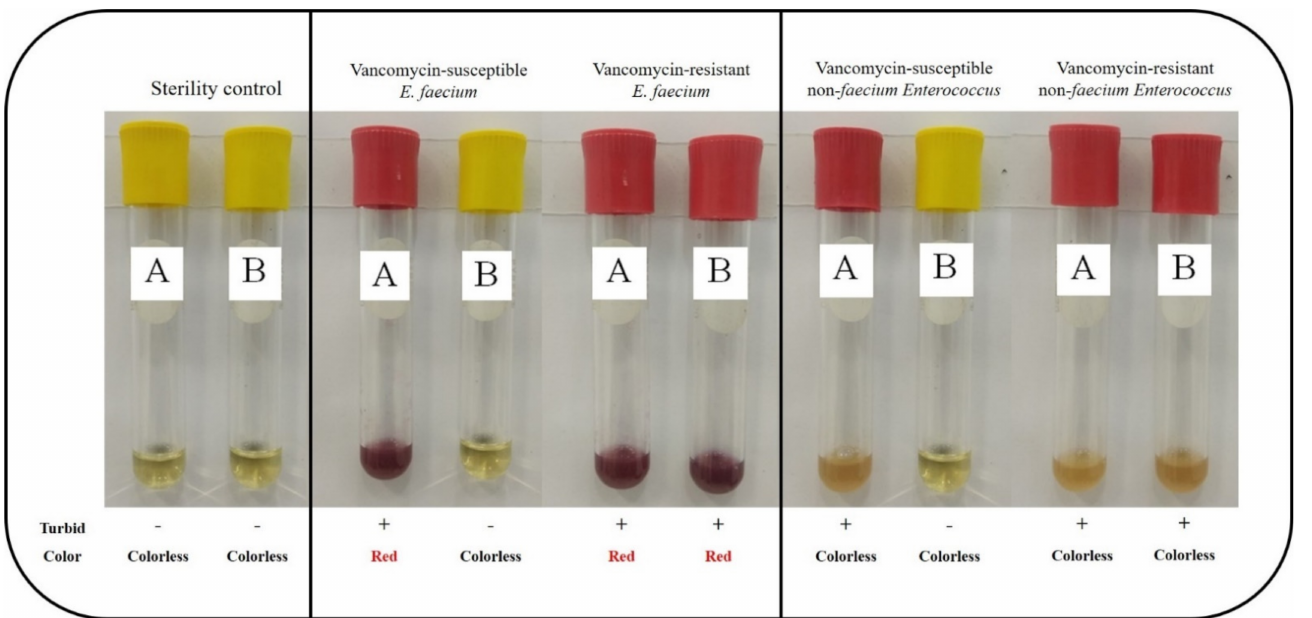
Figure 2. Interpretation of in-house VREfm screening broth for vancomycin-resistant enterococci (VRE) and vancomycin-susceptible enterococci (VSE).